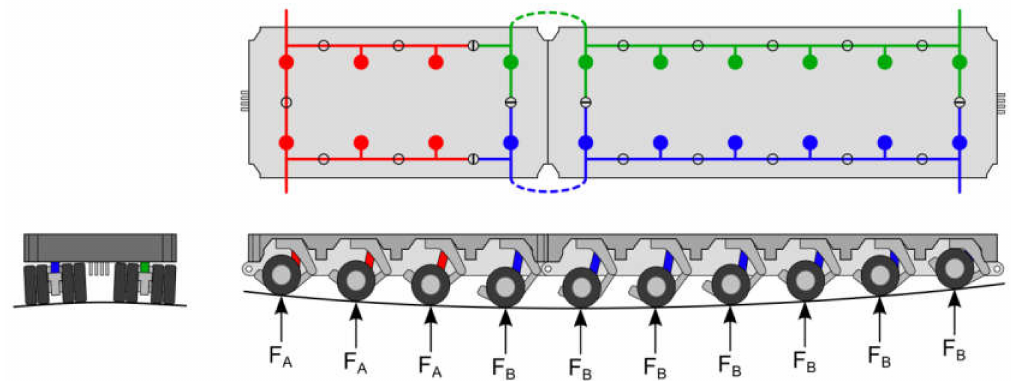
Figure 2. Hydraulic suspension